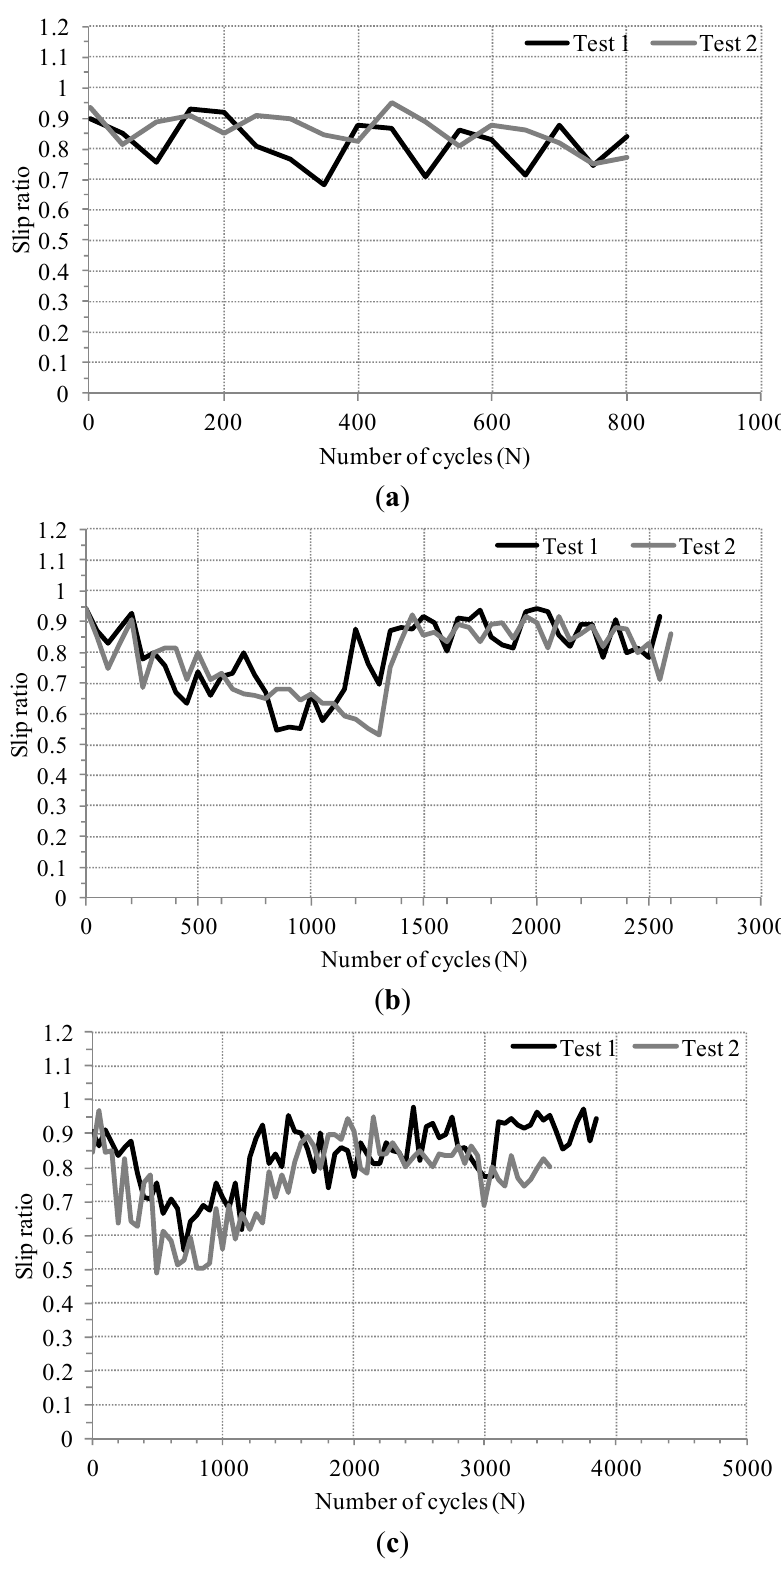
Figure 5. The evolution of slip ratio: ( a ) Conventional (AISI 52100); ( b ) Si 3 N 4 ; and ( c ) ZrO 2